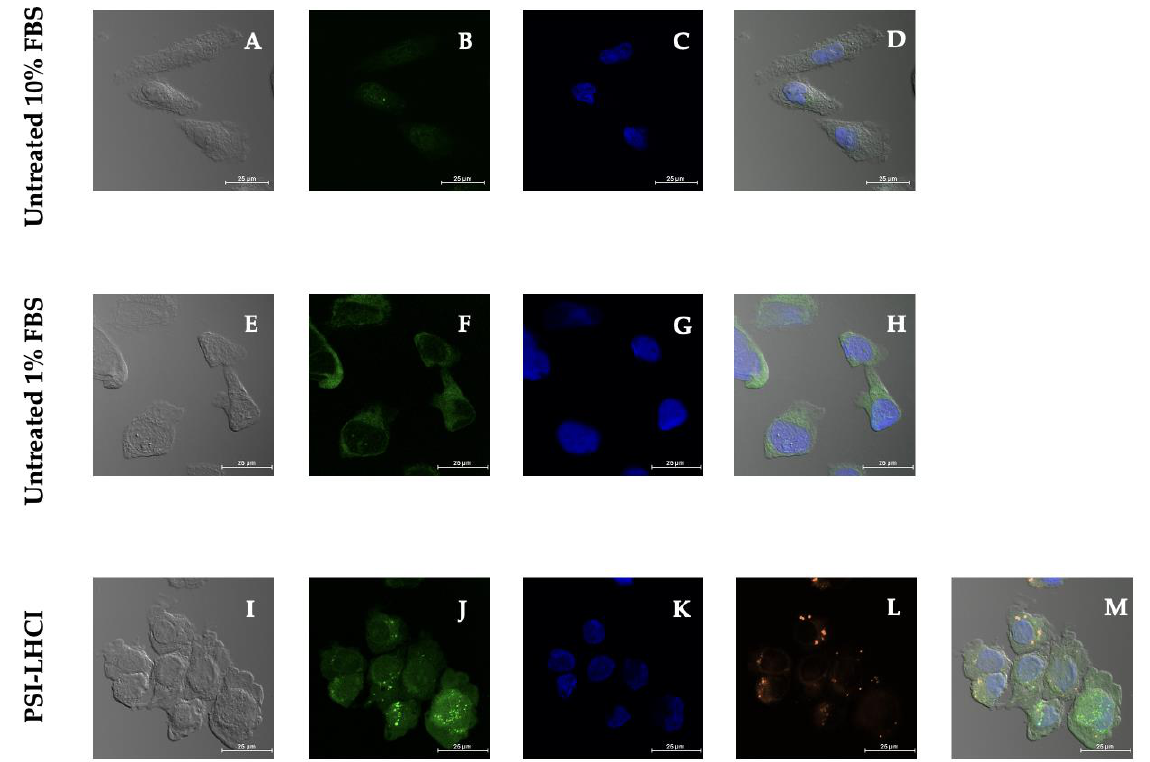
Figure 8 . Autophagy confocal microscopy studies in MDA-MB-231 cells. Phase-contrast ( A , E , I ) and merged images ( D , H , M ) of MDA-MB-231 cells, untreated cells tested in 10% FBS, 1% FBS, and cells treated with PSI-LHCI (12.5 µg/mL), respectively. Blue DAPI nuclear stain ( C ) and green autophagic vesicles ( B ) of cells in complete medium. Blue DAPI nuclear stain ( G ) and green cytoplasm autophagic signal ( F ) of cells in a serum-deprived medium. MDA-MB-231 cells after 24 h of incubation with PSI-LHCI in a serum-deprived medium. Green autophagic vesicles ( J ), blue DAPI nuclear stain ( K ), and PSI-LHCI ( L ) after treatment. All images were taken at 40× magnification. Scale bars, 25 μm.